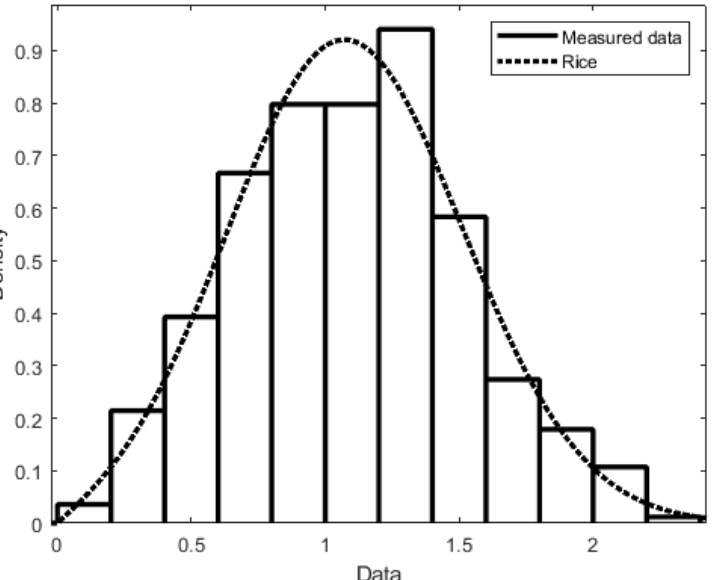
Figure 18. Rice distribution fitting fast variations within the small lab #3 at 5.8 GHz in empty con-